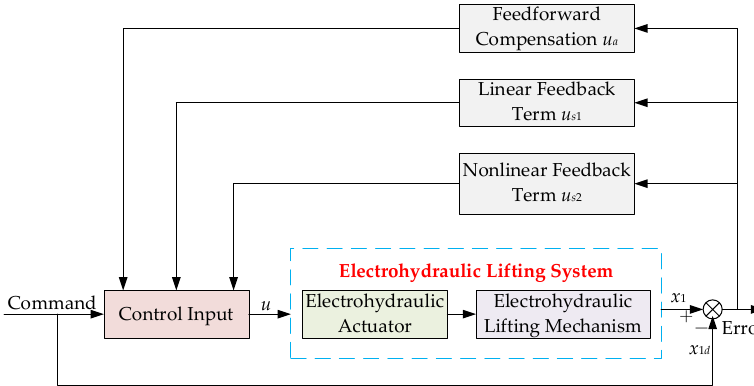
Figure 2. The control diagram of the lifting mechanism.